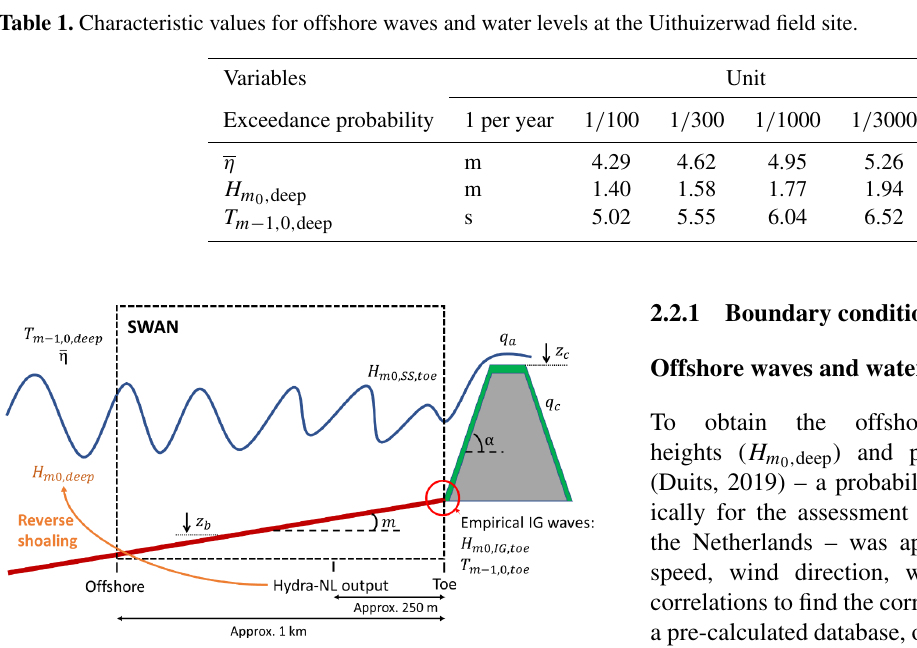
Figure 3. Schematic representation of the dike–foreshore system, showing the areas where key parameters and tools are